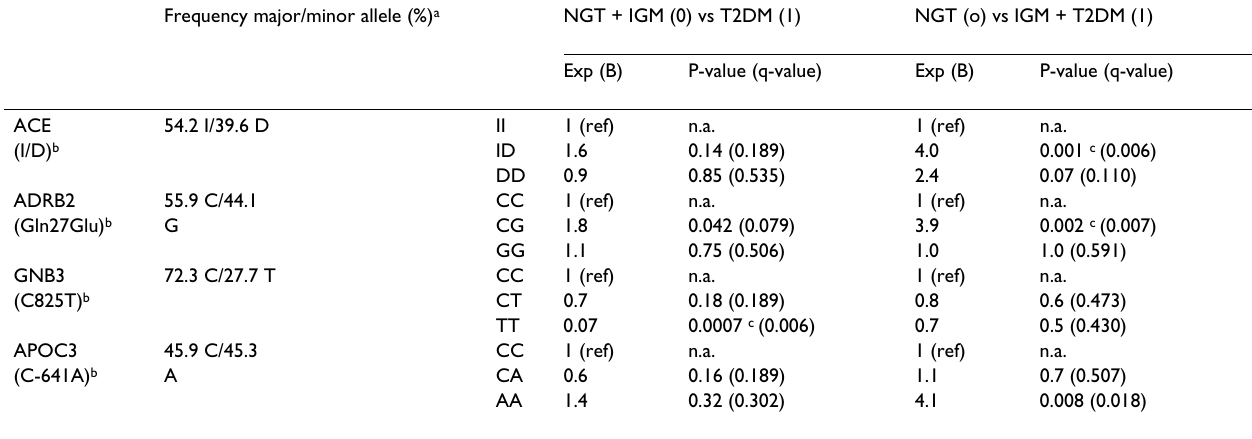
Table 3: Polymorphisms with main effects as independent predictors of disease status. q-value is the adjusted P-value using the procedure of Storey and Tibshirani [12]. Frequency major/minor allele (%)